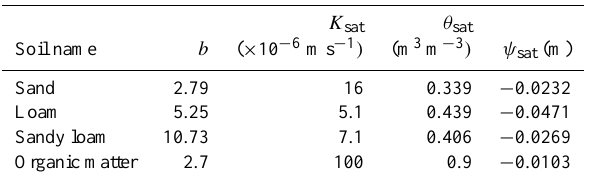
Table 3. Physical properties of the different typical soils for the comparison of soil evaporation efficiencies computed from different